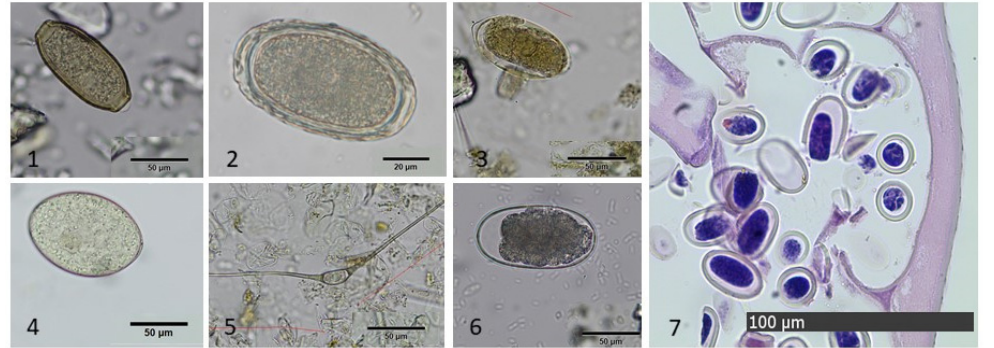
Figure 5. Detected eggs of nematodes and trematodes of Egyptian geese ( Alopochen aegyptiaca ) in Germany and Luxemburg by using the SAF technique: ( 1 ) Capillaria bursata , ( 2 ) Hystrichis tricolor , ( 3 ) Syngamus trachea , ( 4 ) Echinostoma spp., ( 5 ) Notocotylus spp., ( 6 ) Amidostomum anseris , and ( 7 ) Echi ‐ nuria uncinata in the wall of a proventriculus of an Egyptian goose, HE ‐ stained.